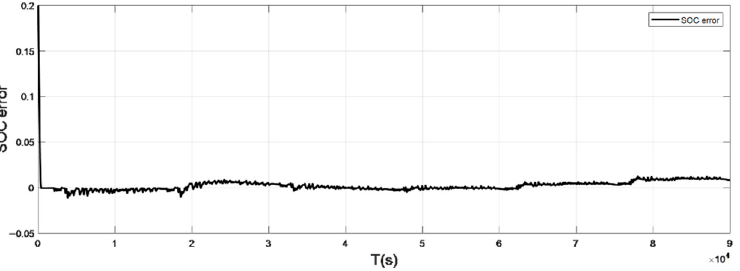
Figure 18. Comparison of the SOC real value and estimated value under UDDS (high temperature: 50 °C).